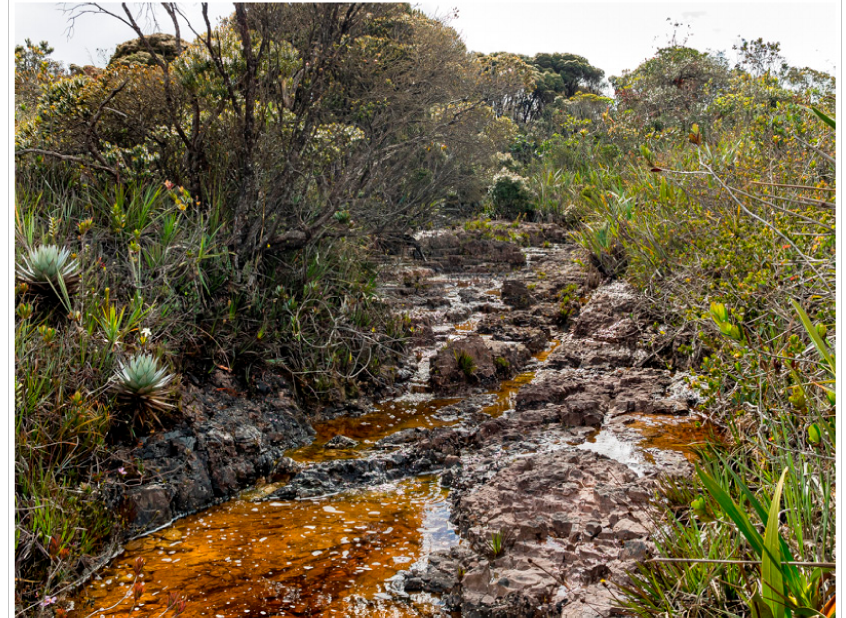
Figure 2. Wetland environment on the summit of Akopan-tepui in Venezuela.